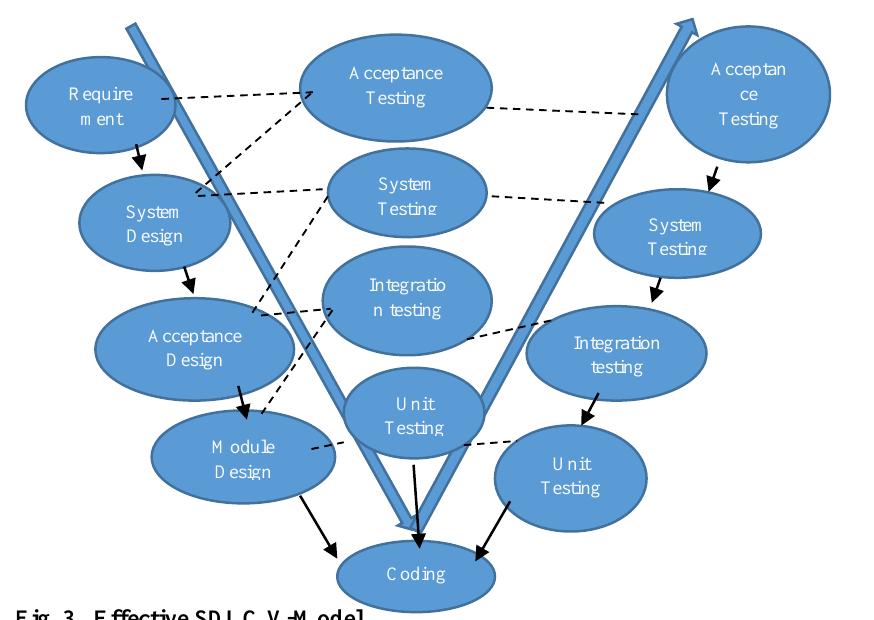
Fig. 3. Effective SDLC